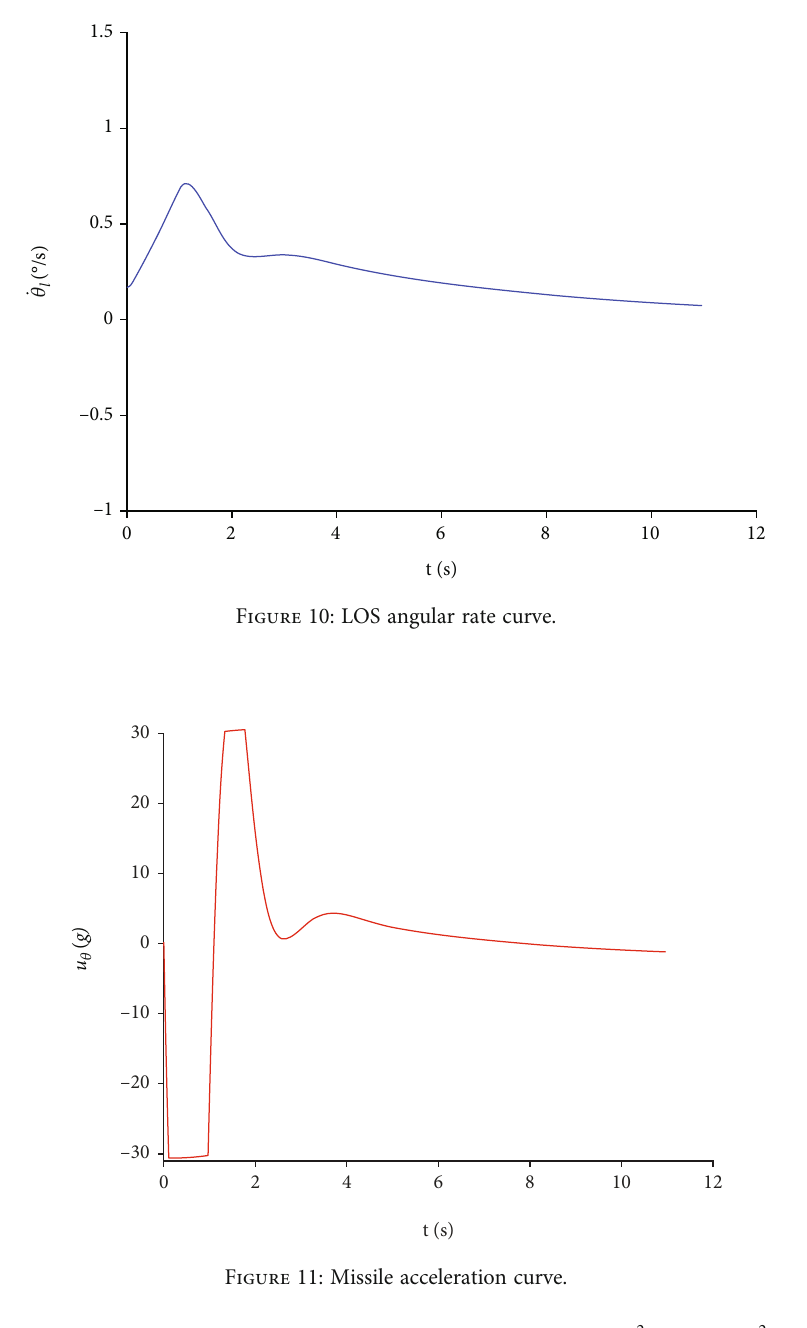
Figure 11: Missile acceleration